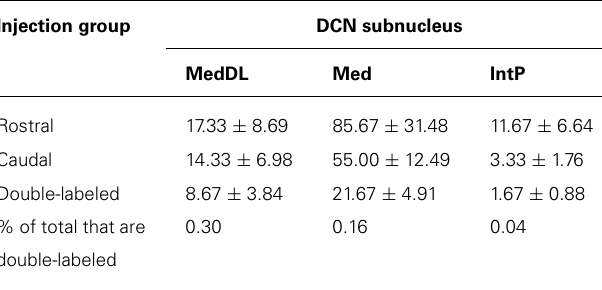
Table 1 |Average number ( ± SEM) of cells labeled in mDCN and IntP subnuclei from animals in which both rostral and caudal brainstem injections were made ( n =